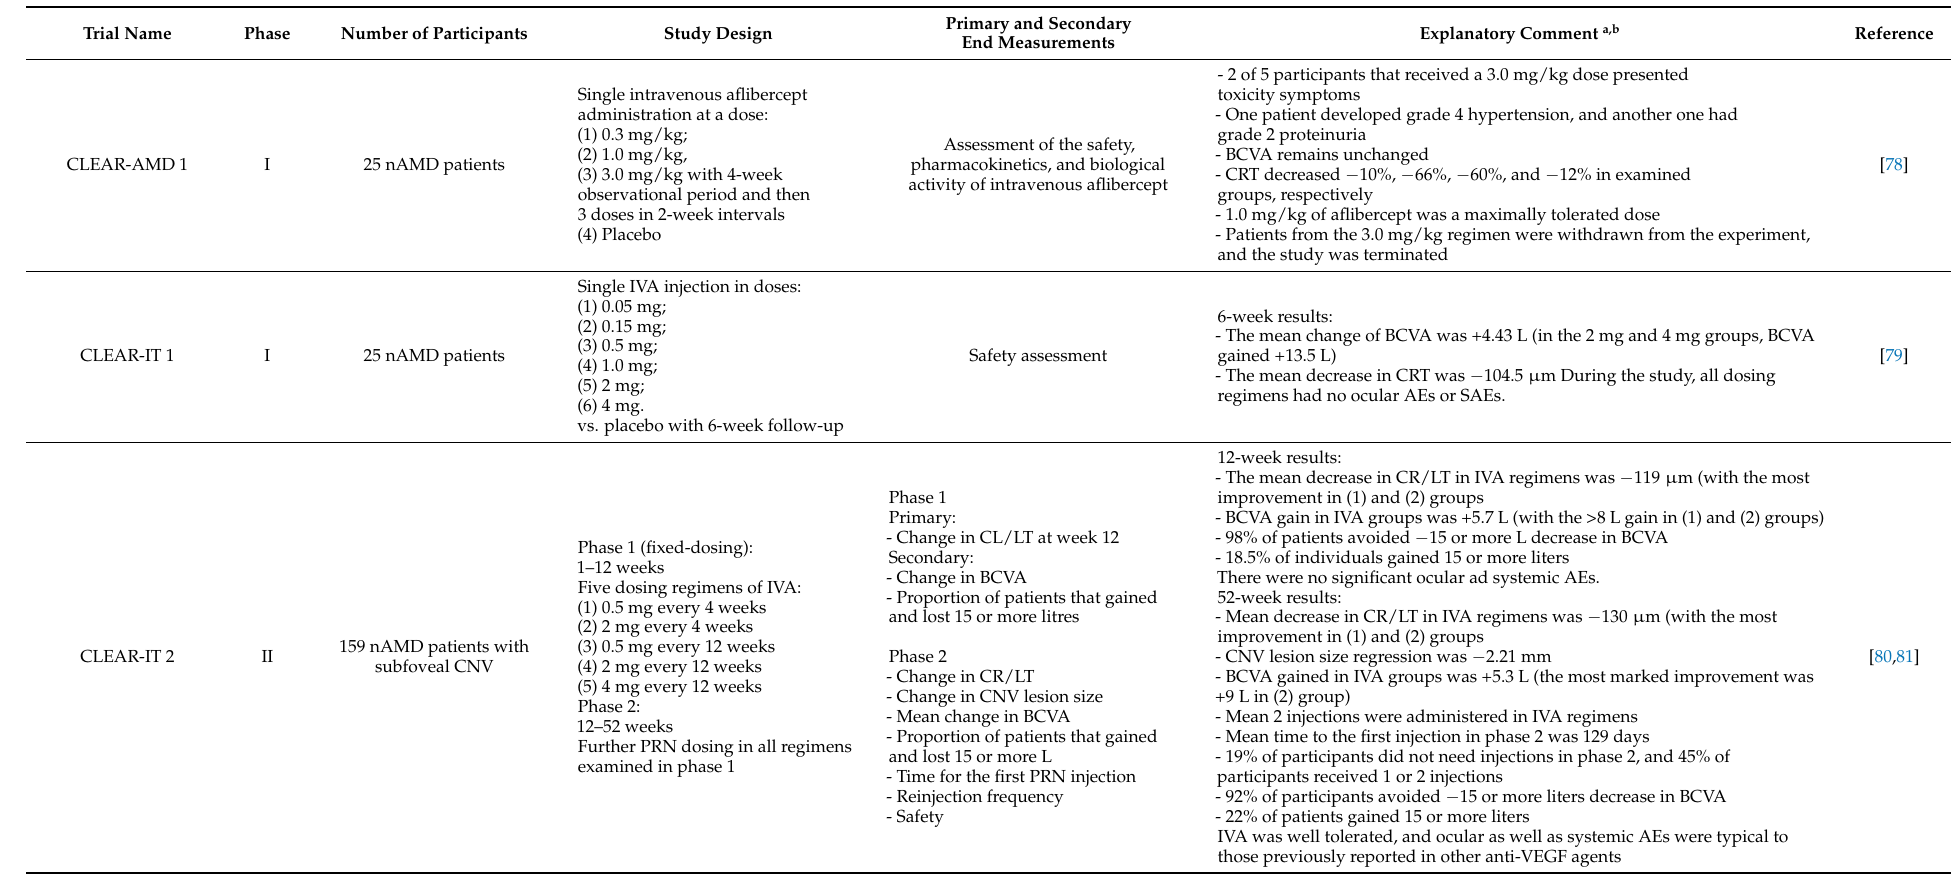
Table 2. Summary of clinical trials assessing the use of aflibercept in the treatment of